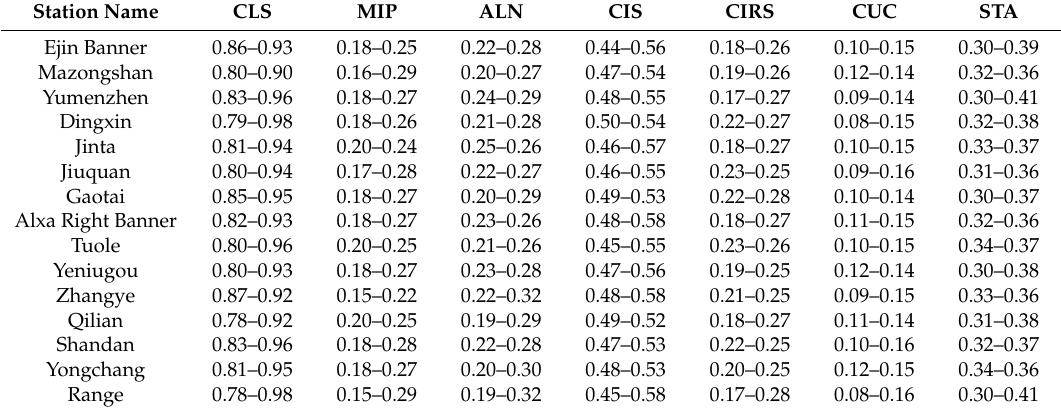
Table 3. The range of the FY-2D cloud type sunshine factors (FY-2D-SF) in different meteorological